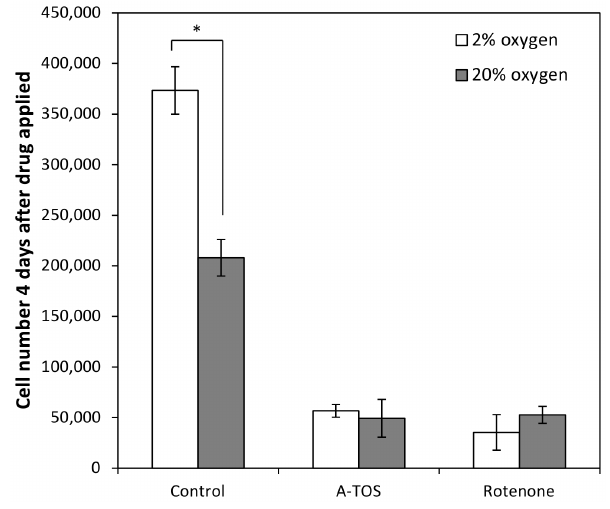
Figure 5. Effect of blocking complex I and II on human embryonic stem cell growth. Effect of blocking complex I and complex II on hESC growth at 20% and 2% oxygen. Plot shows the cell number per well 4 days after the addition of rotenone or D- a - tocopherol succinate (A-TOS) or to the cell culture medium block complex I and II respectively. Control has no drug added. Values are averages 6 standard deviation, n=3. * indicates a p-value , 0.5, deemed statistically significant.